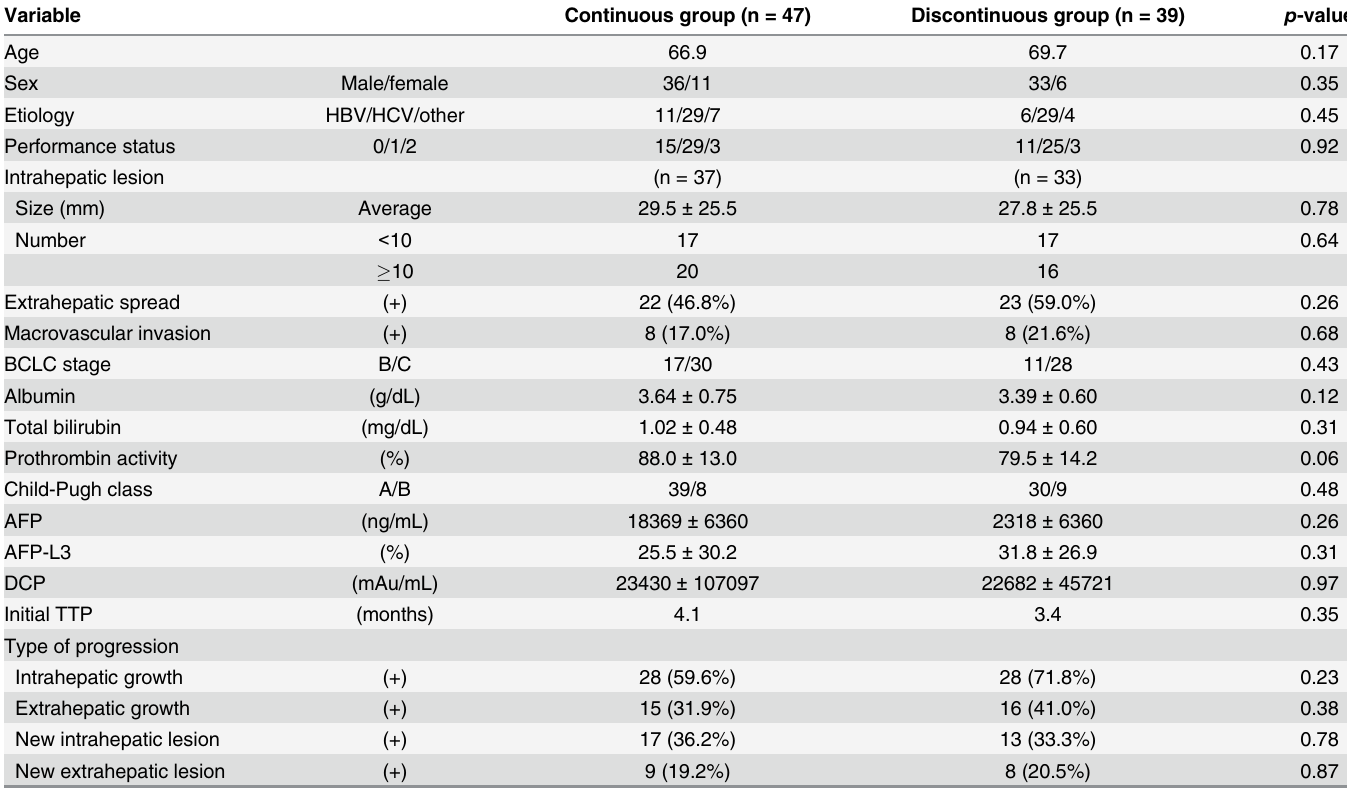
Table 1. Clinical characteristics at the time of radiologic confirmation of progressive disease.